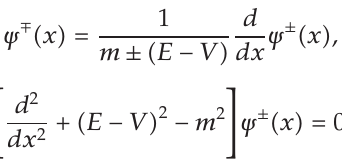
Figure 1 (cid:4) . Otherwise, these solutions are exponentials (cid:3) i.e., in the white areas of the figure (cid:4) . The oscillatory positive/negative energy solutions are located in the light/dark grey